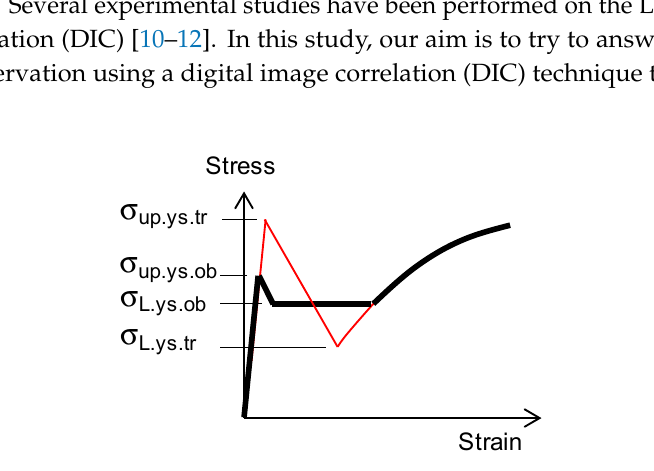
Figure 1. Black lines represent a schematic diagram of the stress-strain curve with Lüders deformation. Red lines represent the Schwab-Ruff model [7].